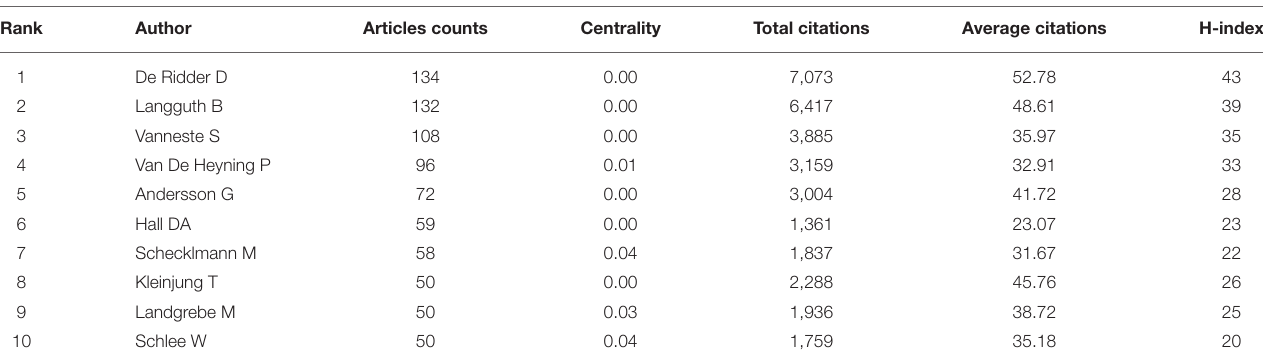
TABLE 3 | Ranking of top 10 most published authors in tinnitus research from 2001 to 2020.